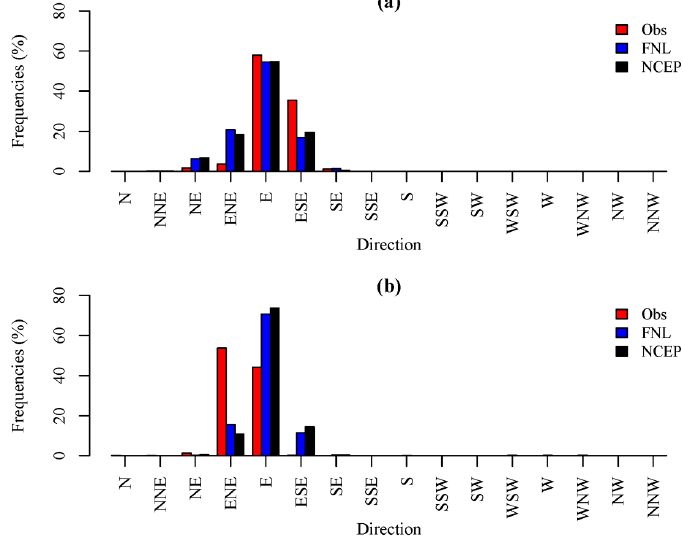
Figure 9. 10 m level wind direction distribution at ( a ) Crown Point and ( b ) Piarco from in-situ data (red bars) compared with WRF model simulations initialized with FNL data (blue bars) and those with NCEP reanalysis data (black bars).